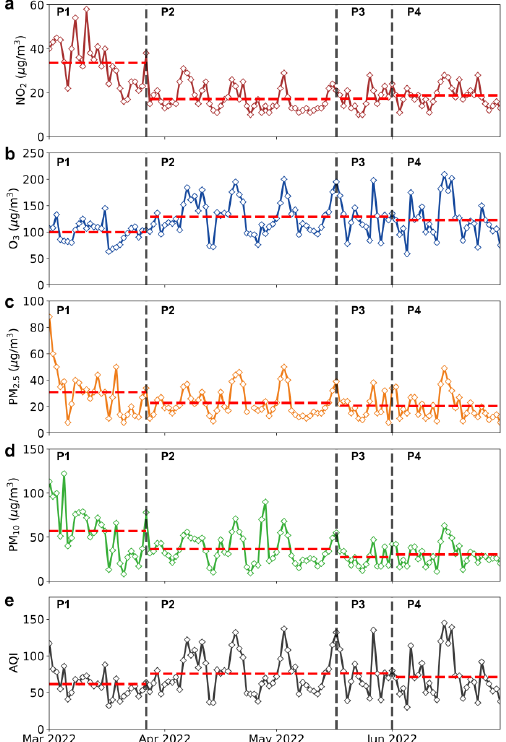
Figure 2. Time series of daily average NO 2 ( a ), PM 2.5 ( b ), PM 10 ( c ), MDA8 O 3 concentrations ( d ), and the daily AQI ( e ), based on in situ measurements over Shanghai from P1 to P4 in 2022. The dashed red line indicates the mean value in each period.